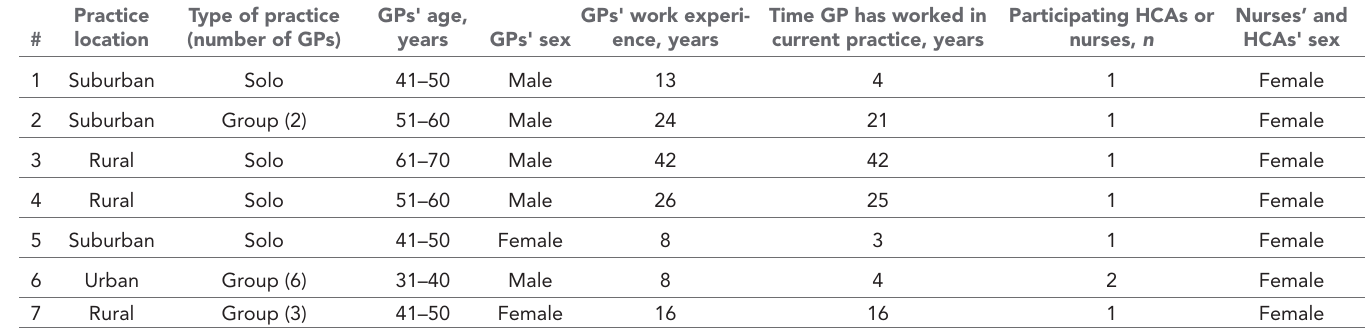
Table 1 Characteristics of practices and participants (GPs, nurses, and